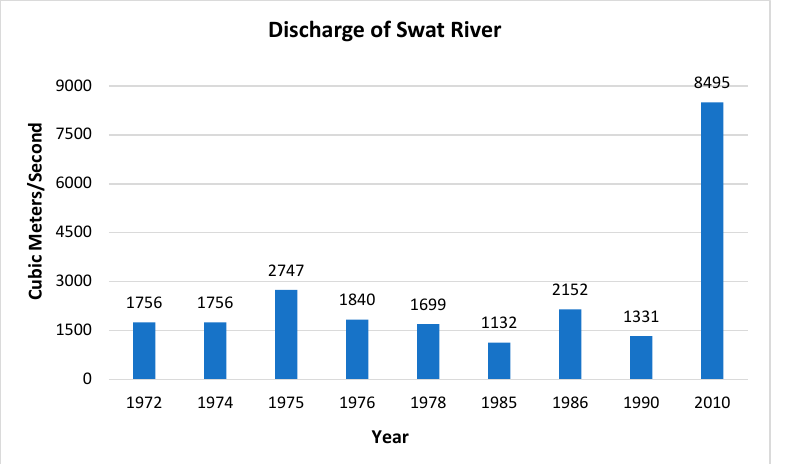
Figure 2. Discharge of River Swat.